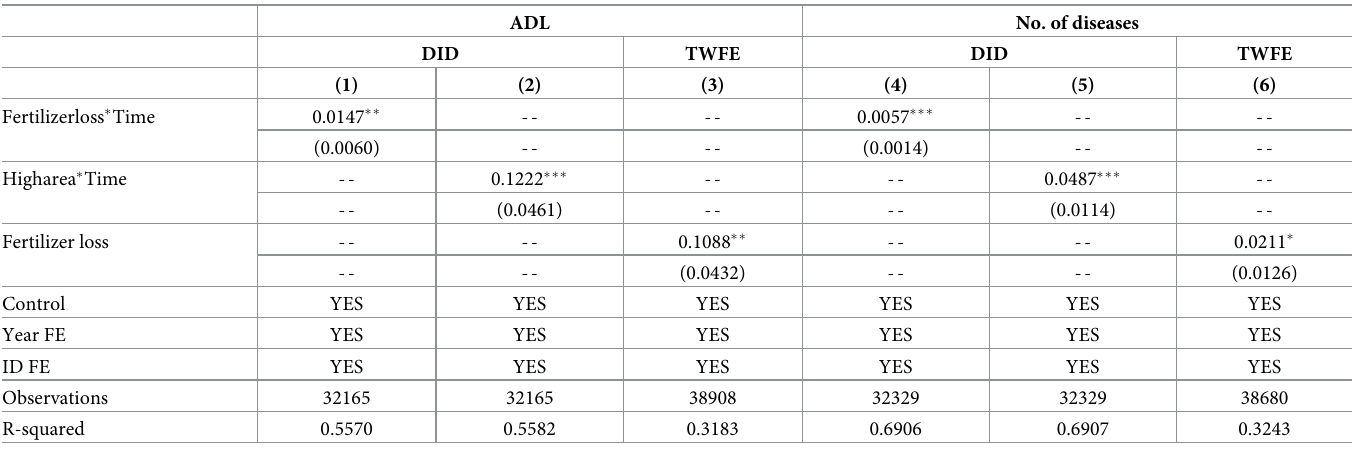
Table 3. Basic estimates ADL index and